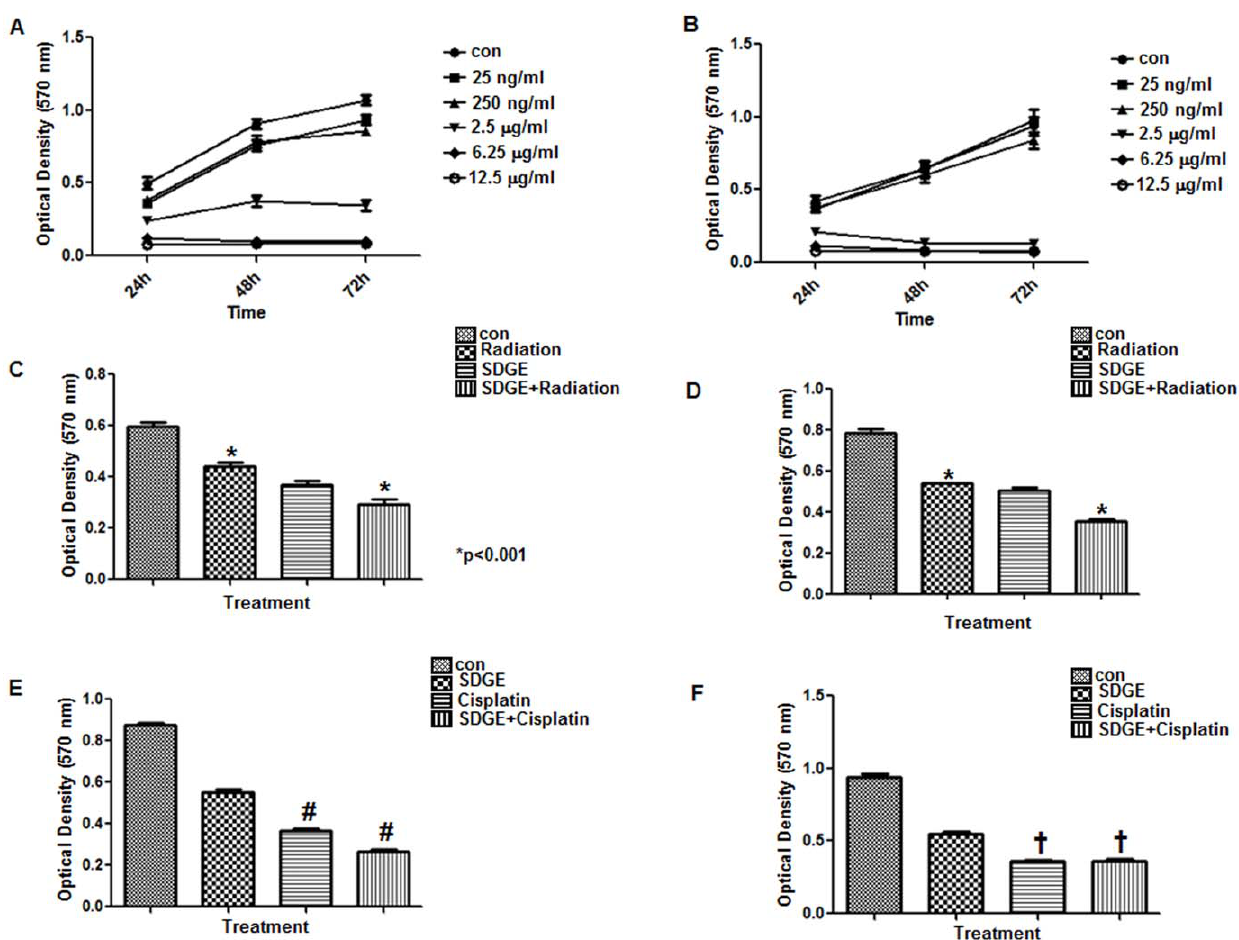
Figure 1. SDGE inhibits the proliferation of endometrial cancer cell lines. Effect of SDGE on cell proliferation was determined by conducting MTT assays. The cells Ishikawa (A), and ECC-1 (B) were incubated with the depicted concentrations of SDGE for 24, 48, and 72 h. Optical density at 570 nm was determined to quantify the number of live cells in the cultures. Control (Con) wells in all experiments were treated with DMSO, the vehicle control. Cumulative data for SDGE isolated from three different batches of ginger rhizomes is shown. Each data point in all figures is mean of 48 individual readings. Anti-proliferative effect produced by SDGE (2.5 m g/ml) in Ishikawa (C and E) and ECC-1 (D and F) cells was comparable to treatment of these two cell lines with radiation (C and D) or cisplatin (E and F). The cells were simultaneously treated with SDGE and radiation (4 Gy) or cisplatin (5 m M). MTT assays were conducted to determine the effect of these treatments on the proliferation of the Ishikawa and ECC-1 cell lines. Each bar in C–F represents a mean of eight replicates. *p , 0.001, # p , 0.05, and { p . 0.05 (not